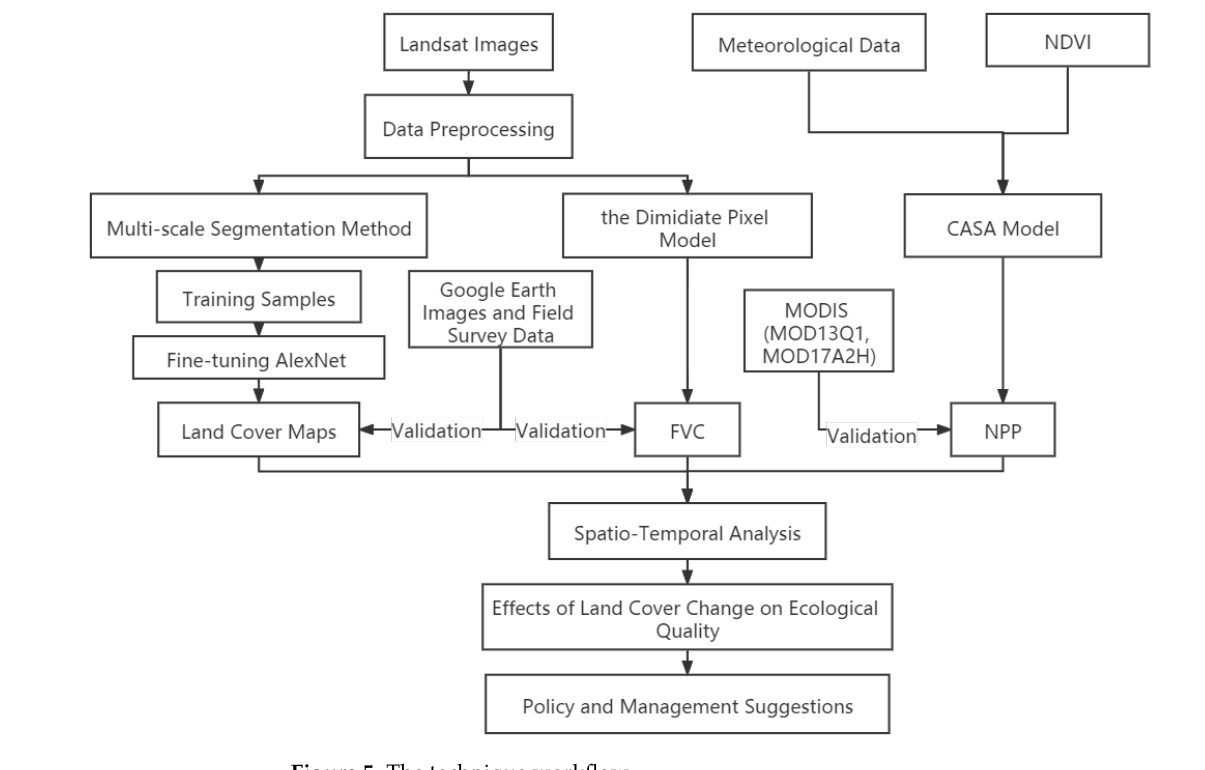
Figure 5. The technique workflow.